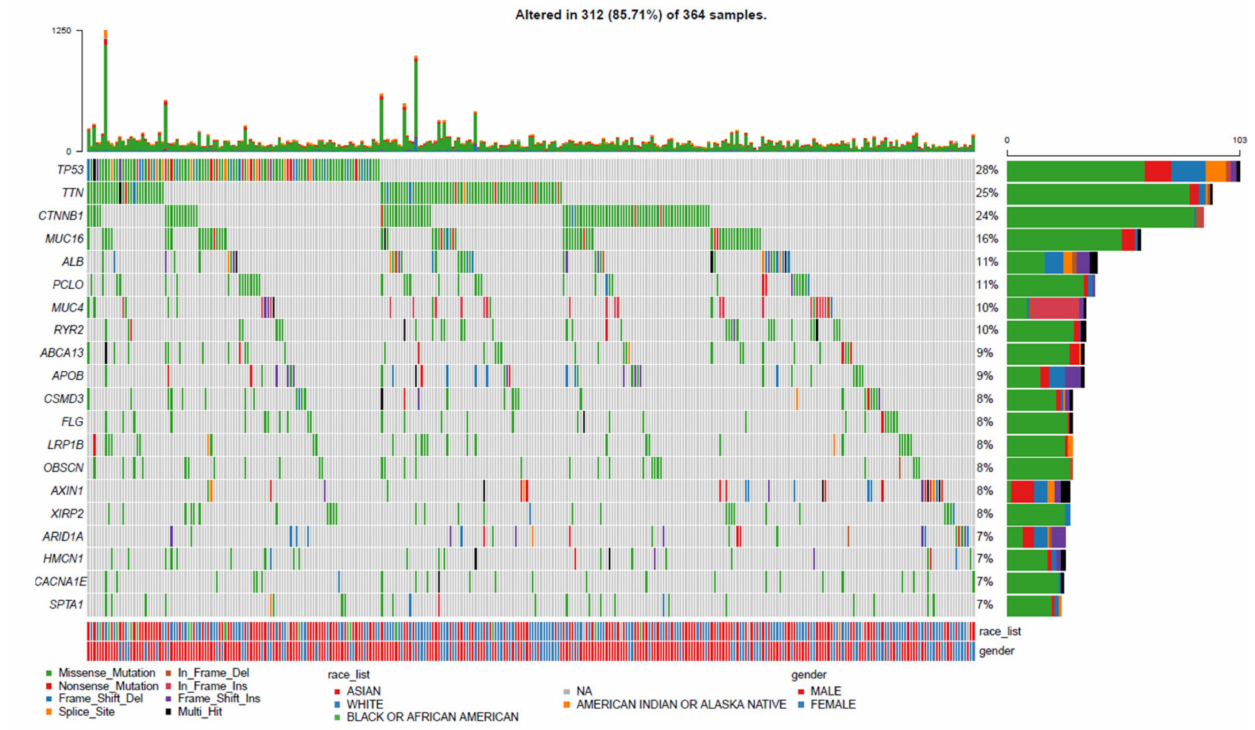
Figure 1. Landscape profile of top 20 mutated genes in 364 LIHC from TCGA database. Mutations of each gene in each sample are shown in waterfall plot. Each column presents specific sample, each line presents mutated gene, and name is listed on left. Different forms of somatic mutations and percentages of gene mutation types are shown on right (color version of figure is available